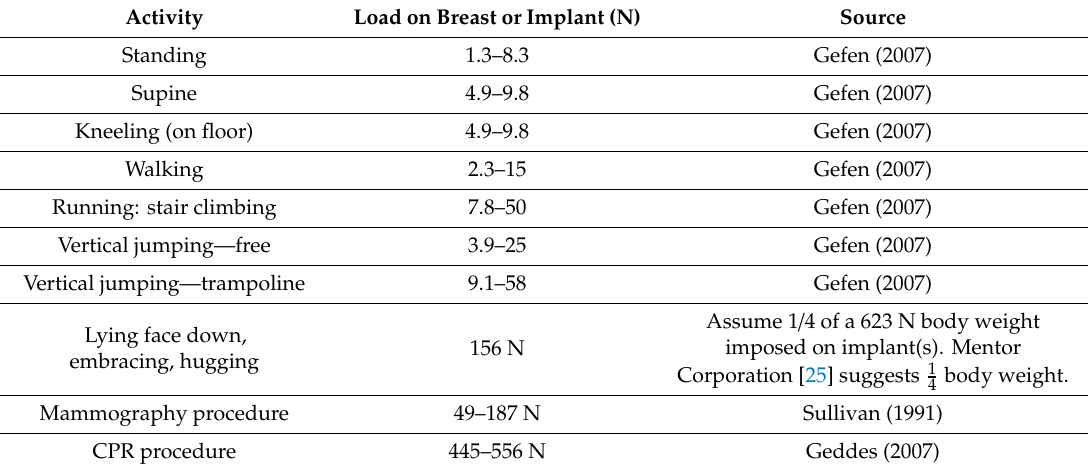
Table 4. Typical loads on a woman’s breast & breast